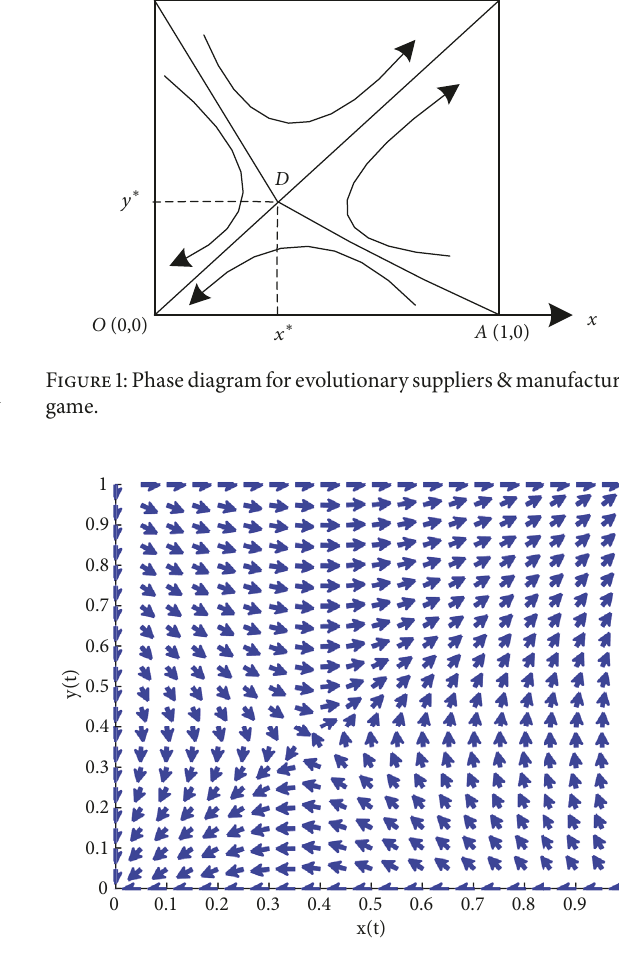
Figure 2: Convergence to ESS for 𝑑𝑥/𝑑𝑡 and 𝑑𝑦/𝑑𝑡